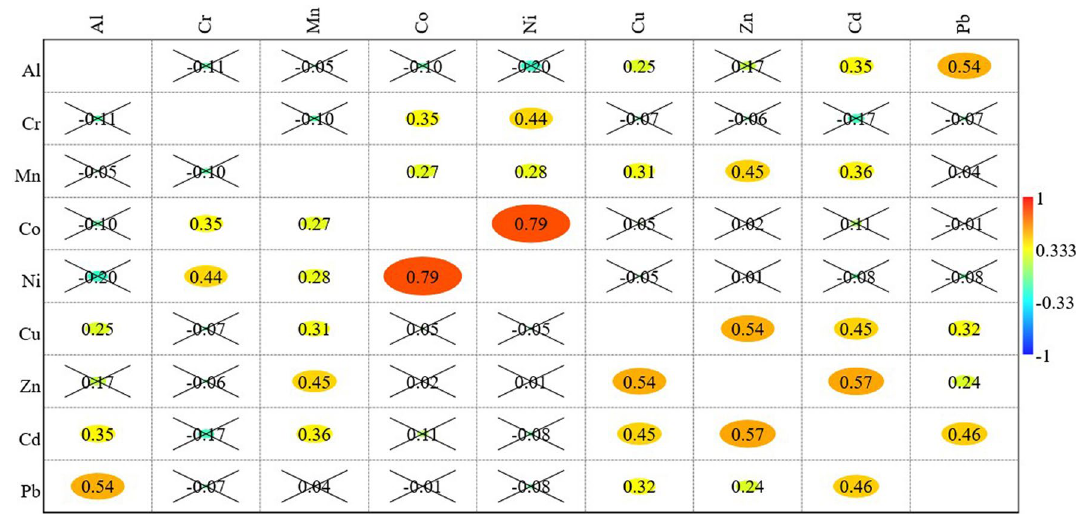
Figure 3. Spearman correlation matrix for different HMs in the groundwater